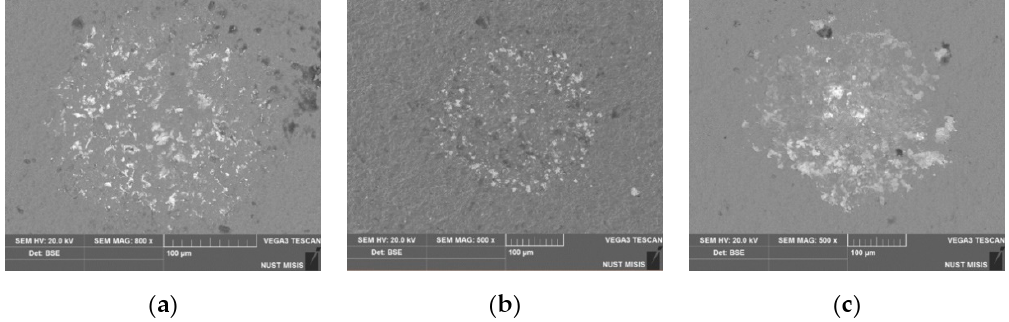
Figure 7. SEM micrographs of impact cavities after testing in air at an applied load of 250 N for 1 × 10 4 cycles: ( a ) Ti–Al–N; ( b ) Ti–Al–Cu–N; and ( c ) Ti–Al–Ni–N coatings.